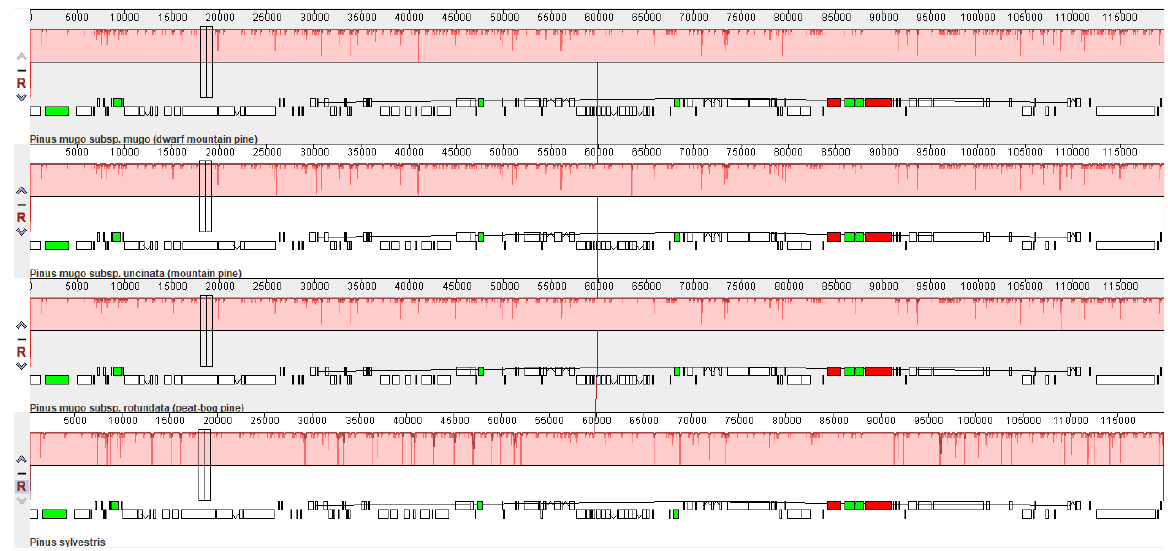
Figure 2. MAUVE alignment of three Pinus mugo complex representatives; P. mugo subsp. mugo , P. mugo subsp. uncinata , P. mugo subsp. rotundata . The Pinus sylvestris chloroplast genome is shown at bottom as a reference. Within each of the alignments, local collinear blocks are represented by blocks of the same color connected by lines.